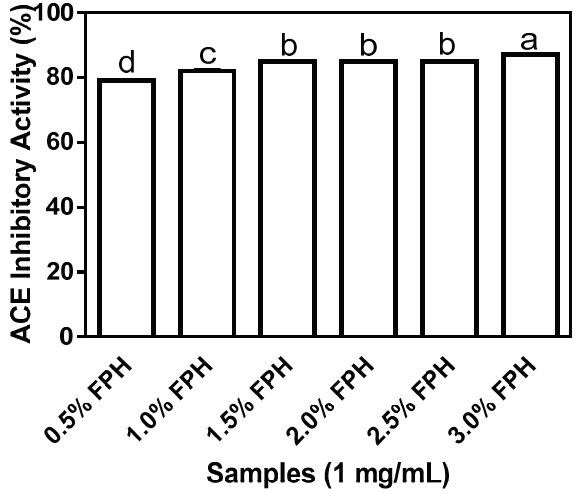
Figure 1. Percentage (mean ± standard error) angiotensin I-converting enzyme- (ACE-) inhibitory activity of flaxseed protein hydrolysates (FPH) digested with thermoase GL-30 (0.5%–3%). Bars with different letters have mean values that are significantly different ( p <